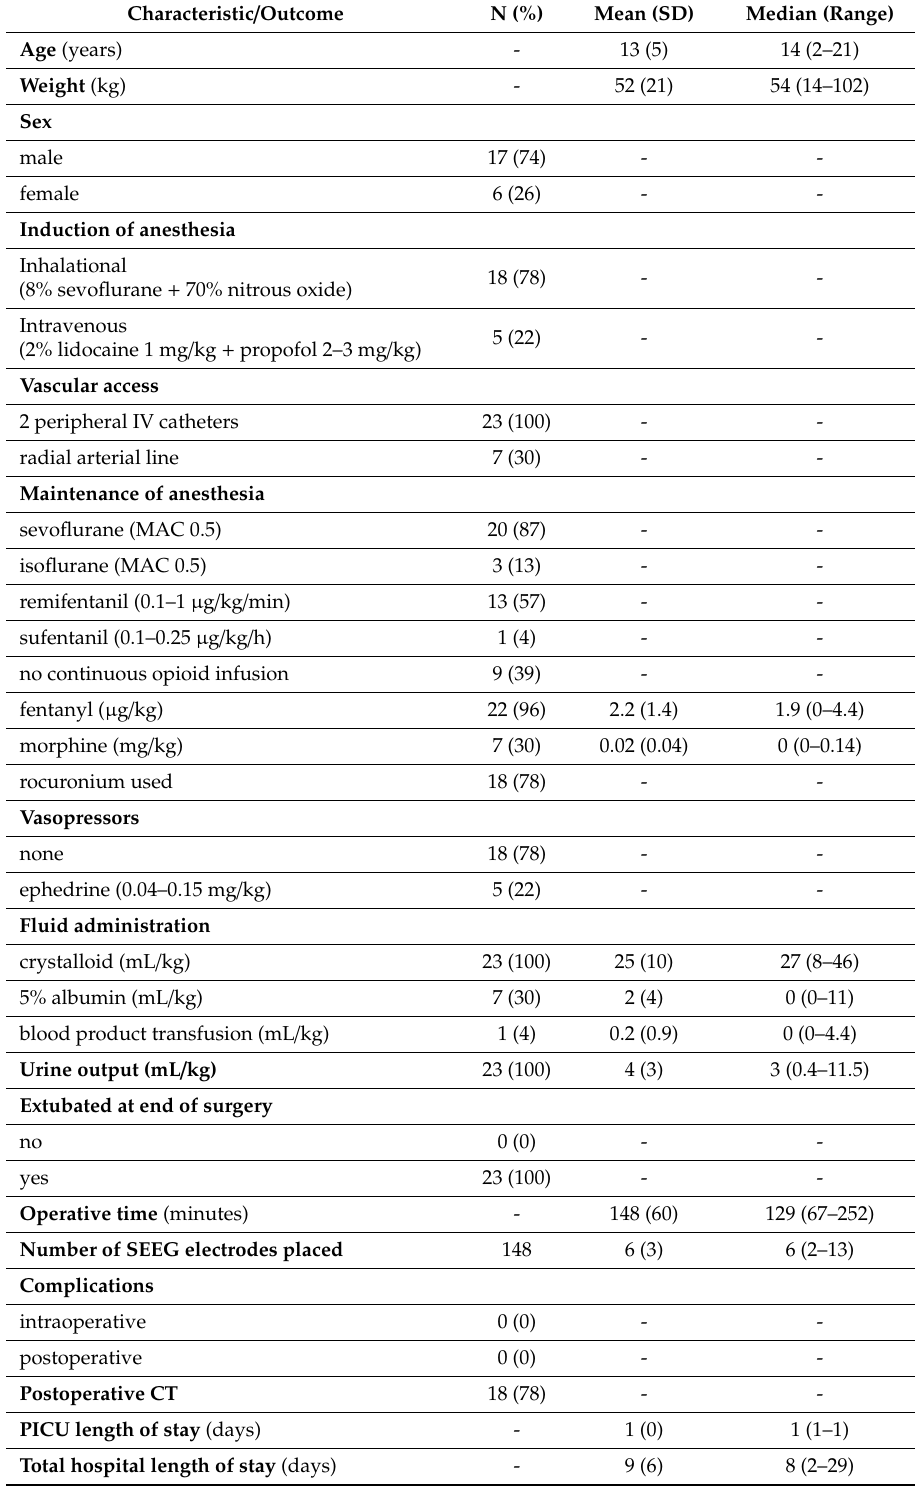
Table 1. Demographics, intraoperative management, and